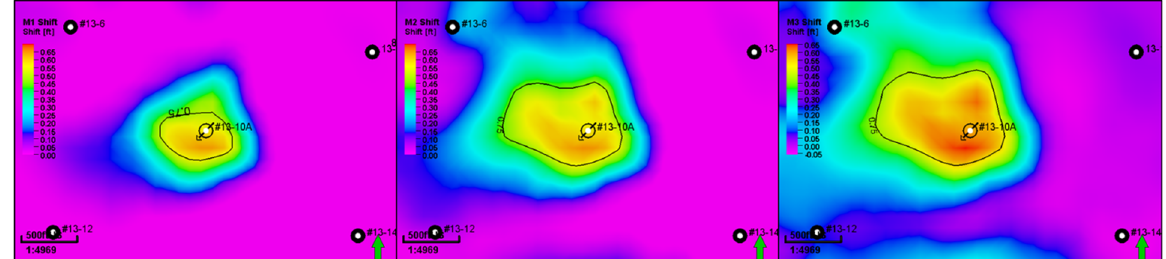
Figure 18. Simulated time-lapse depth shifts mole fraction at monitor times M1 ( left ), M1 ( center ), and M3 ( right ). The xCO 2 = 0.75 contour is shown (black).